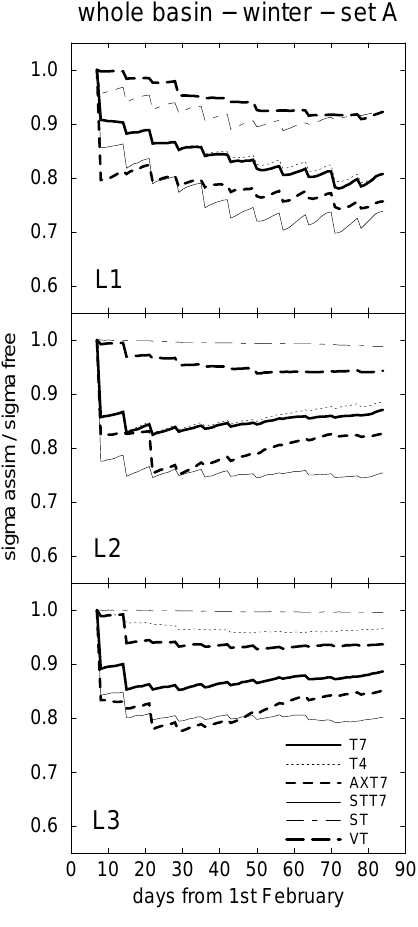
Fig. 4. As Fig. 3 for winter OSSEs. (winter). All the initialization fields are taken from an inter- annual simulation without data assimilation that was started in 1993 and forced by ECMWF 6-hourly